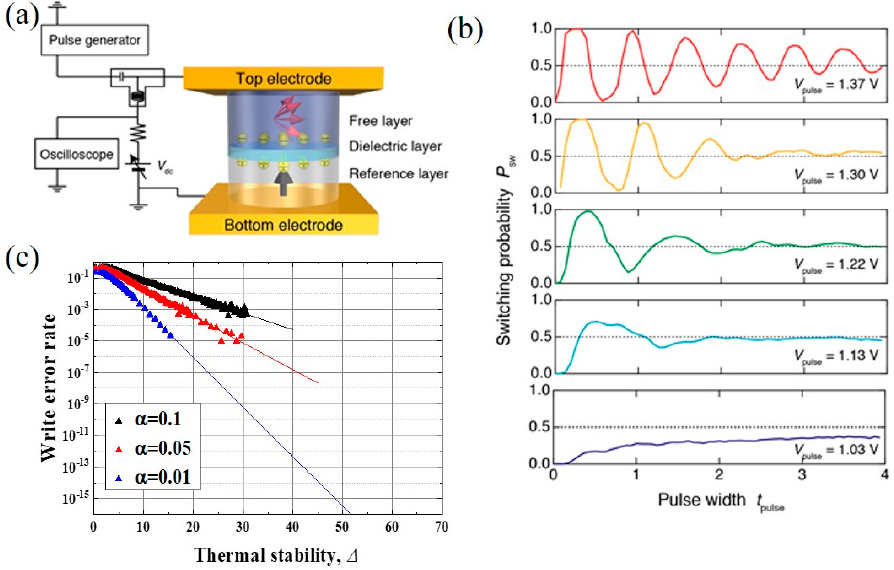
Figure 17. ( a ) Experimental setup for evaluating the WER of an MTJ. ( b ) Pulsed-voltage-driven magnetization switching in a p-MTJ. ( c ) WER as a function of Δ obtained from numerical simulations.